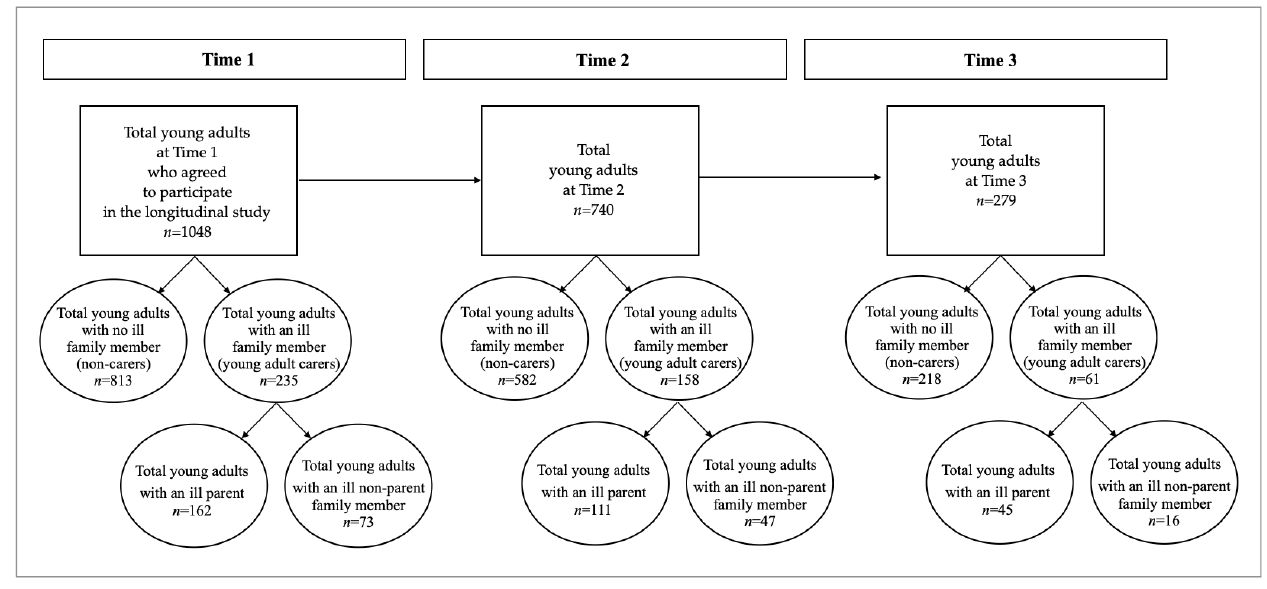
Figure 1. Flow Chart Displaying Participant Enrolment at Each Assessment Point.